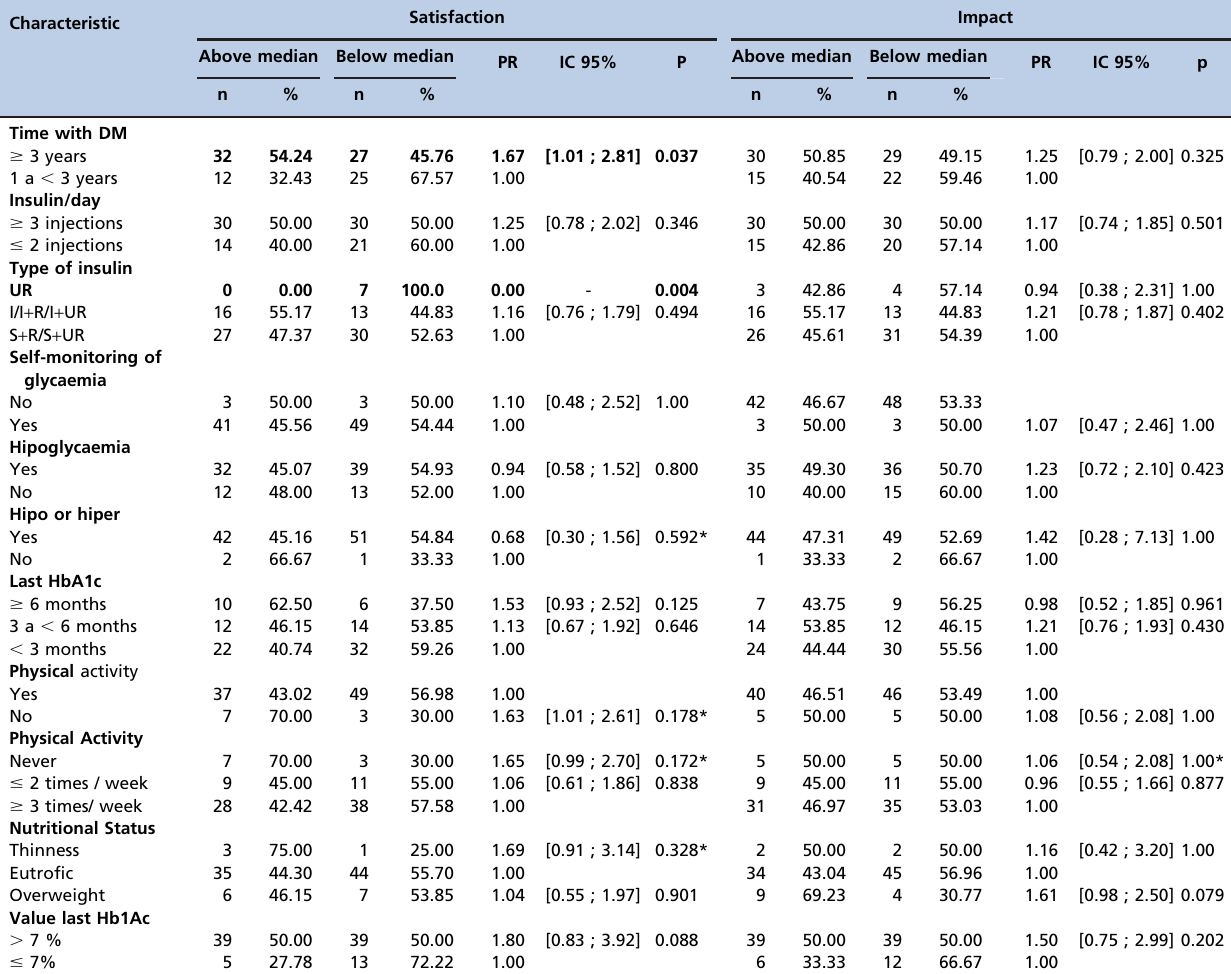
Table 3A - Bivariate analysis of associations between clinical characteristics and the domains ‘‘Satisfaction’’ and